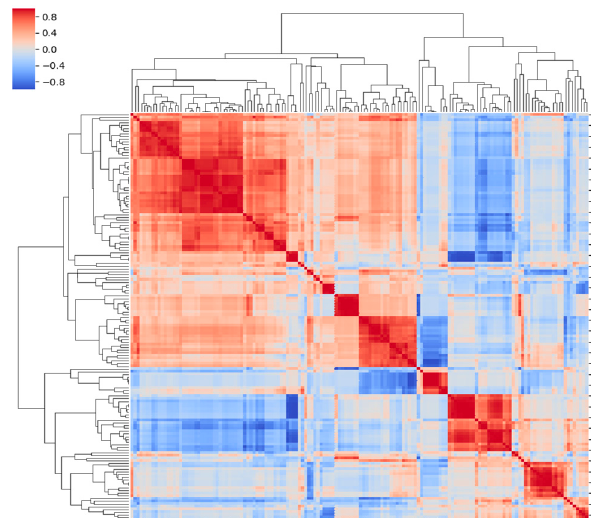
Figure 2. Correlation matrix representing selected imaging features. Colour scale on the left side indicates degree of correlation (from − 1 to 1 and from blue to red).